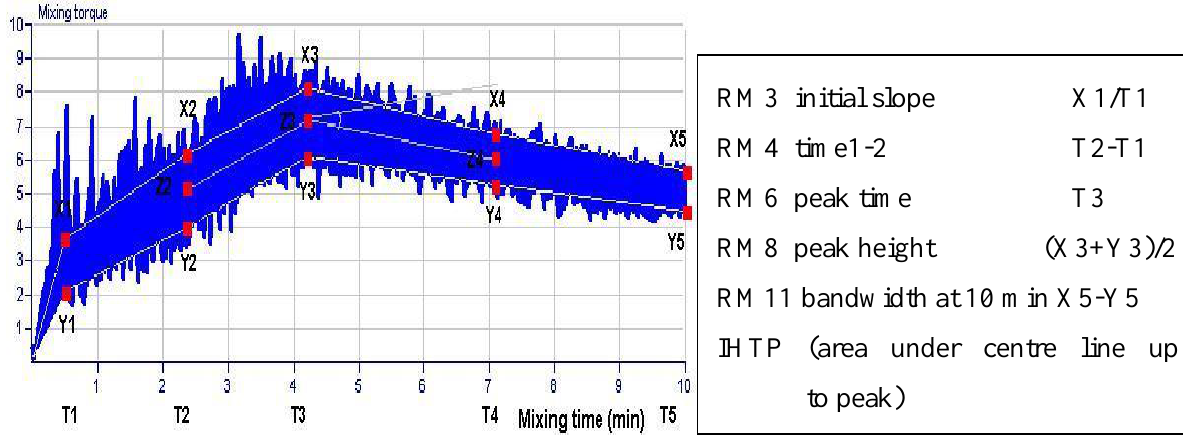
Figure 2. Definition of Reomixer mixing